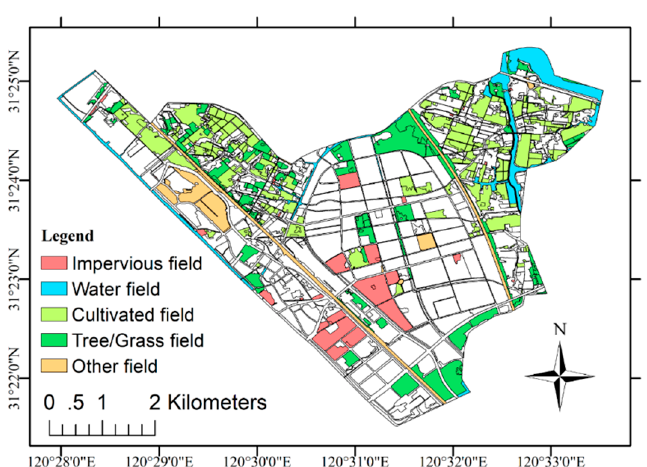
Figure 8. Results of the segmentation and distribution of automatically collected geo-object samples.